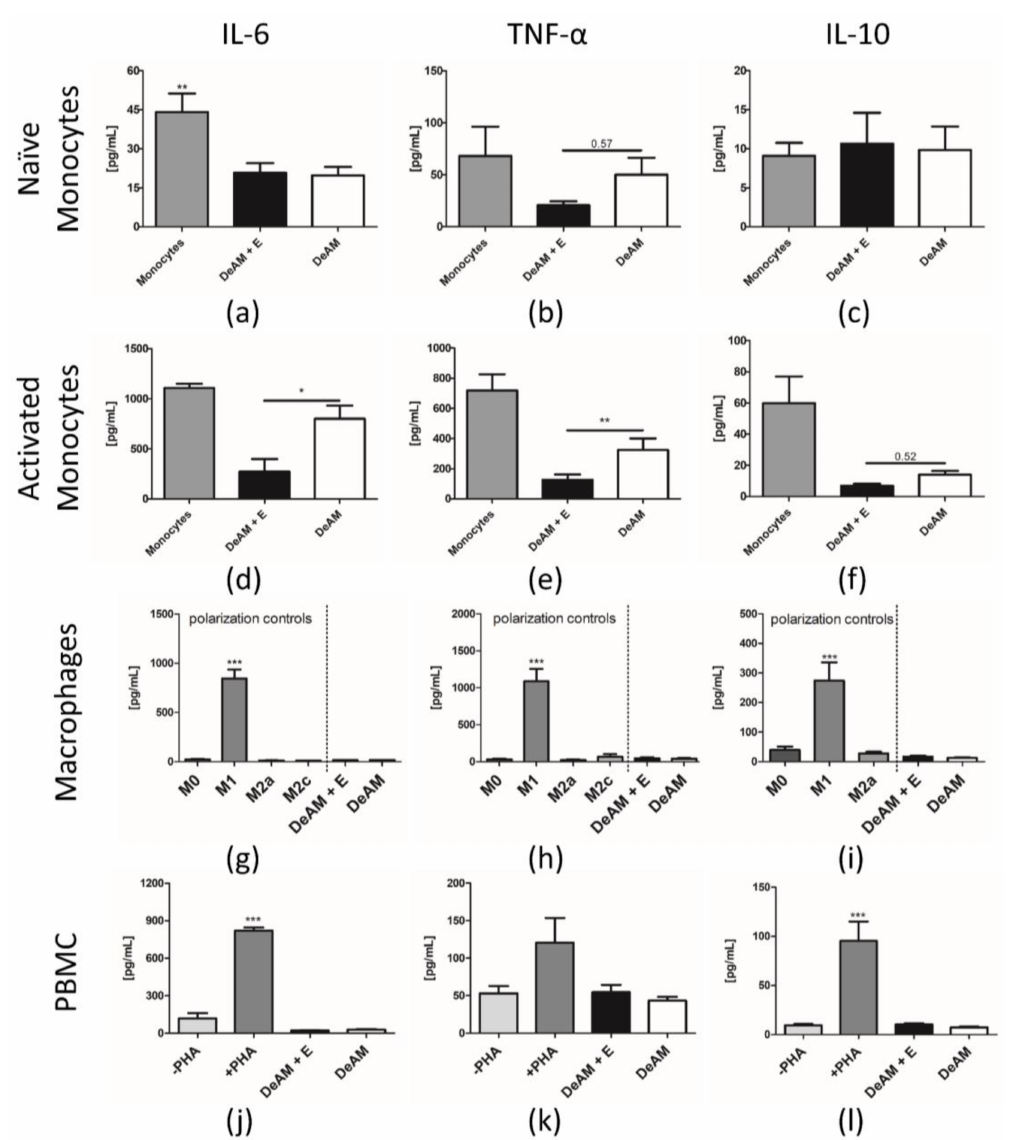
Figure 5. Cytokine release from monocytes, macrophages and PBMCs cultured on DeAM and DeAM + E scaffolds determined by ELISA. Supernatants were collected after 24 h of naïve (( a – c ) ** p < 0.01 to all groups) and LPS-activated (( d – f ) * p < 0.05, ** p < 0.01) CD14+ monocytes on DeAM + E (black), DeAM (white) or monocyte standard culture control conditions (grey). Macrophages derived from CD14 + -monocytes (M0) were polarized towards pro-inflammatory M1- and anti-inflammatory M2a- and M2c-type. After 2 days, supernatants were collected and analyzed for IL-6, TNF- α and IL-10 (( g – i ) *** p < 0.001 to all groups) concentration. PBMCs from human buffy coat were cultured for 5 days. Supernatants were collected and analyzed for cytokine secretion of IL-6, TNF- α and IL-10 (( j – l ) *** p < 0.001 to all groups). The positive control group was stimulated with PHA. n ≥